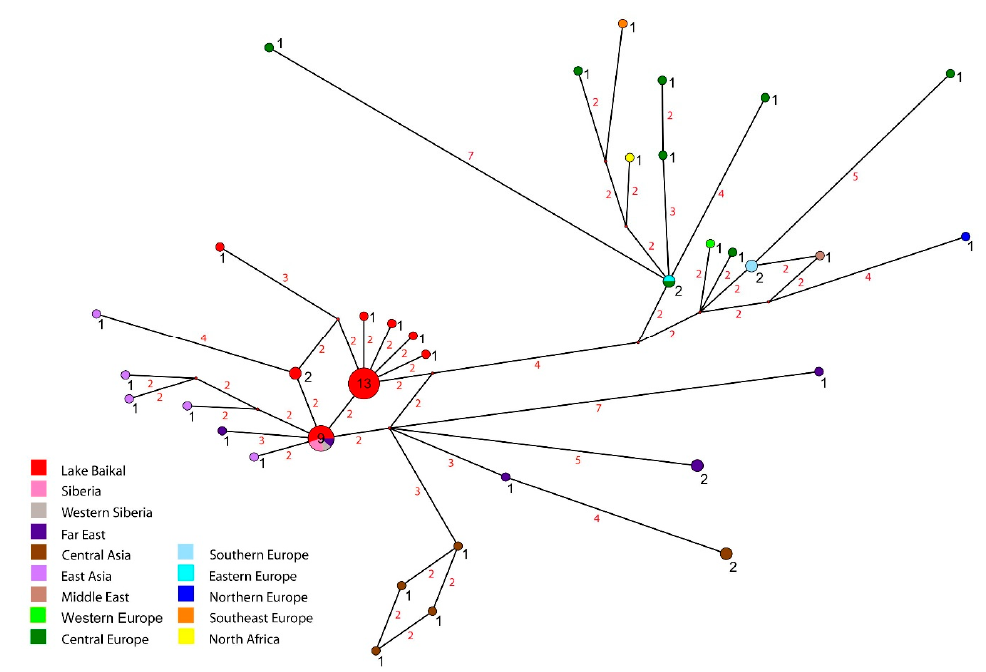
Figure 5. Haplotype network of cyt–b sequences of 61 Radix auricularia specimens from different locations in Asia, Europe, and North Africa. The size of the balloons is proportional to the number of individuals having each haplotype, which corresponds to the black number inside or next to the balloon. The small red dots represent internal haplotypes not represented by the dataset. The length of the connecting lines is proportional to the number of substitutions between haplotypes, corresponding to the red number on the line.